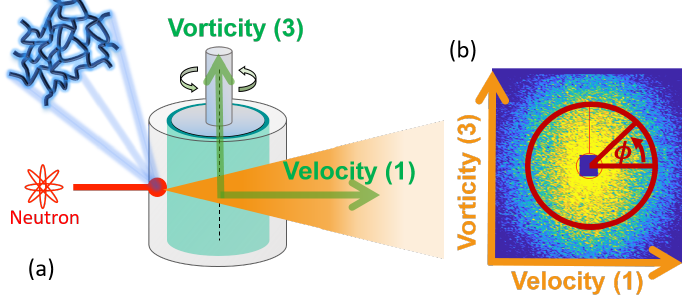
Figure 2. A schematic of the rheo-small-angle neutron scattering (rheo-SANS) experiment setup. ( a ) A quartz couette geometry is used to impose dynamic flow fields. Microstructure is continuously monitored throughout the experiments, as temporally captured by neutron detector, forming the 2D SANS pattern ( b